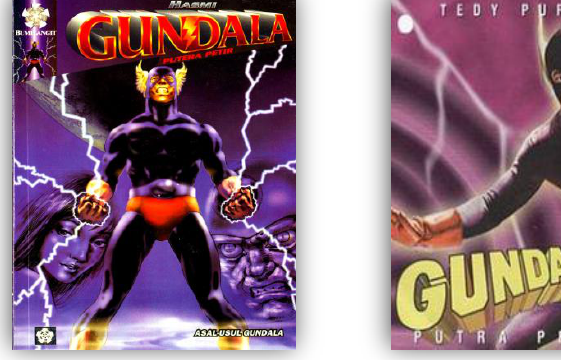
Figure 7. Initial Concept of Gundala by Hasmi